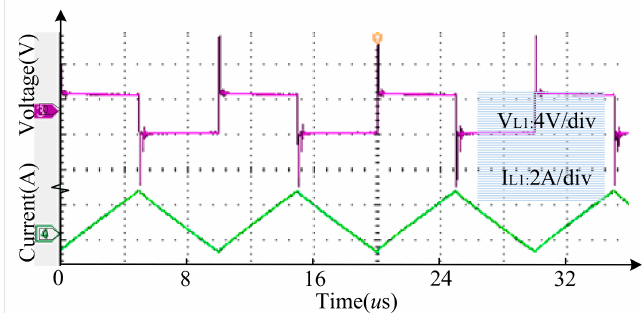
Figure 13. The buck-boost mode balancing waveform from the experiment in the laboratory.